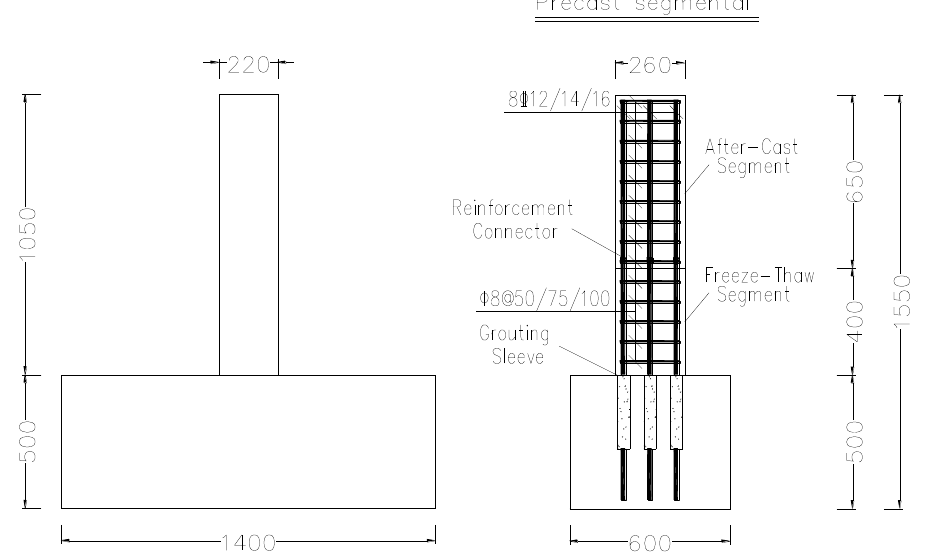
Figure 1. The dimensions and reinforcement details of the specimens (unit: mm). Table 1. Parameters of the specimens.